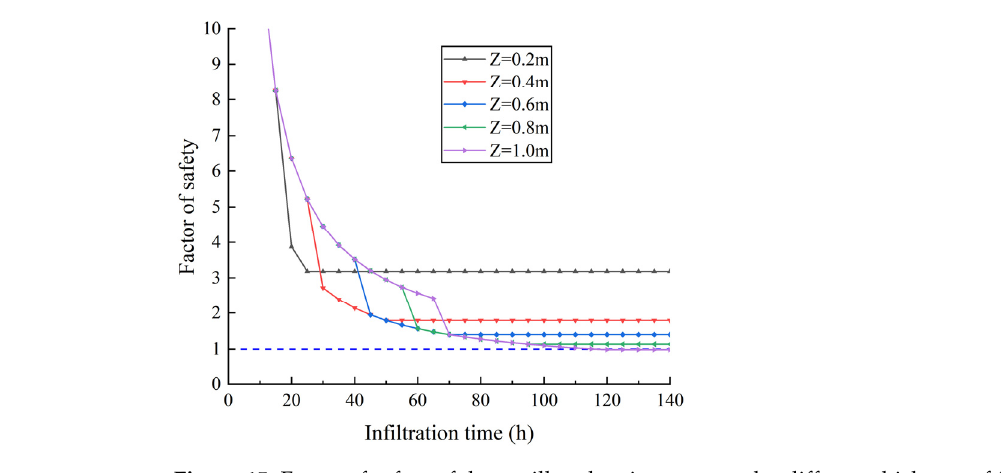
Figure 15. Factor of safety of the capillary barrier cover under different thickness of fine-grained soil